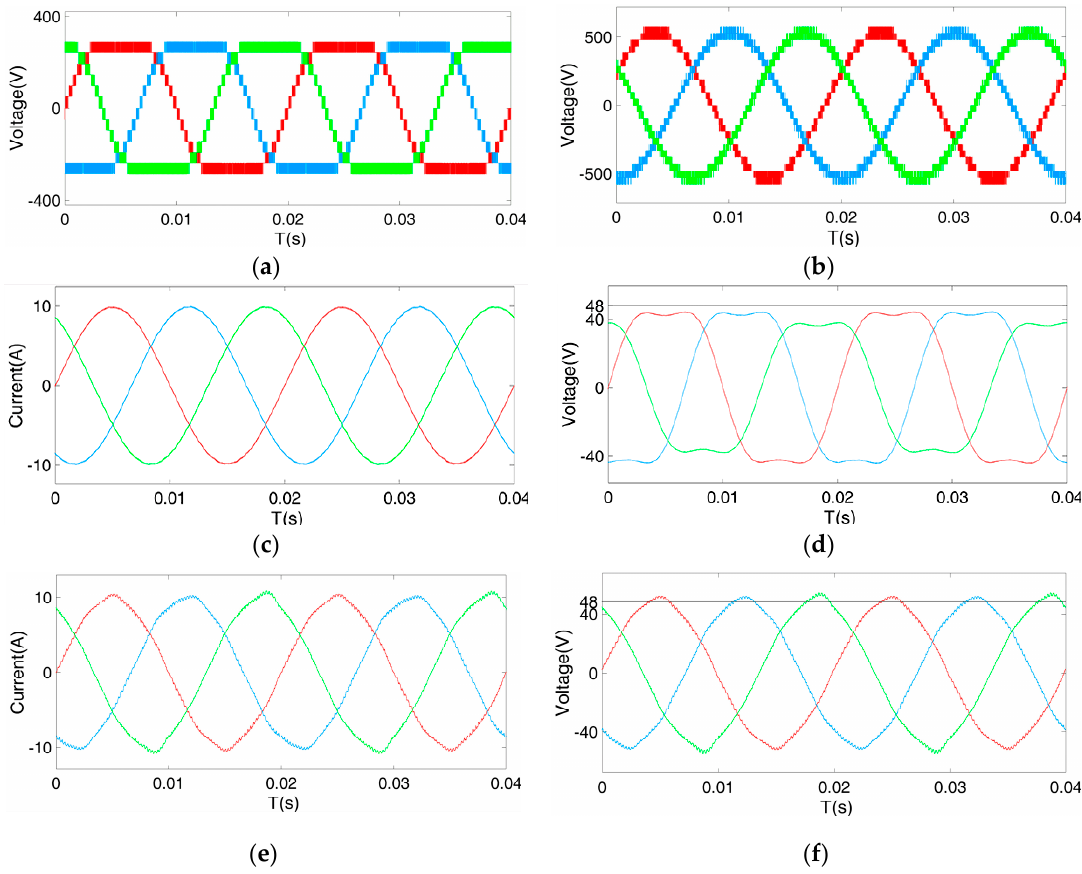
Figure 8. Waveforms for the “667” operation state: the ( a ) three-phase converter output voltage; ( b ) three-phase line-to-line voltages; ( c ) grid current; ( d ) three-phase submodule modulating waveform; ( e ) grid current in FPSC; ( f ) three-phase sub-module modulating waveform in FPSC.